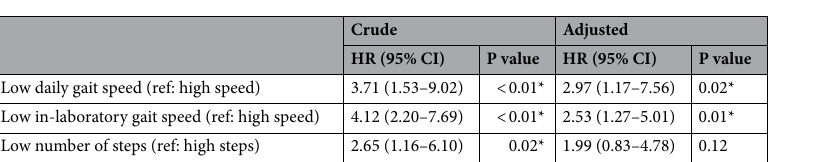
Table 2. Association of gait parameters with disability in the Cox proportional hazard regression model. HR = hazard ratio; ref = reference, * p < 0.05. Low and High daily gait speed: participants with daily gait speed of < 106.3 cm/s and of ≥ 106.3 cm/s, respectively. Low and High in-laboratory gait speed: participants with in-laboratory gait speed of < 100.0 cm/s and of ≥ 100.0 cm/s, respectively. Low and High steps: participants with number of steps of < 6342.2 steps and of ≥ 6342.2 steps,